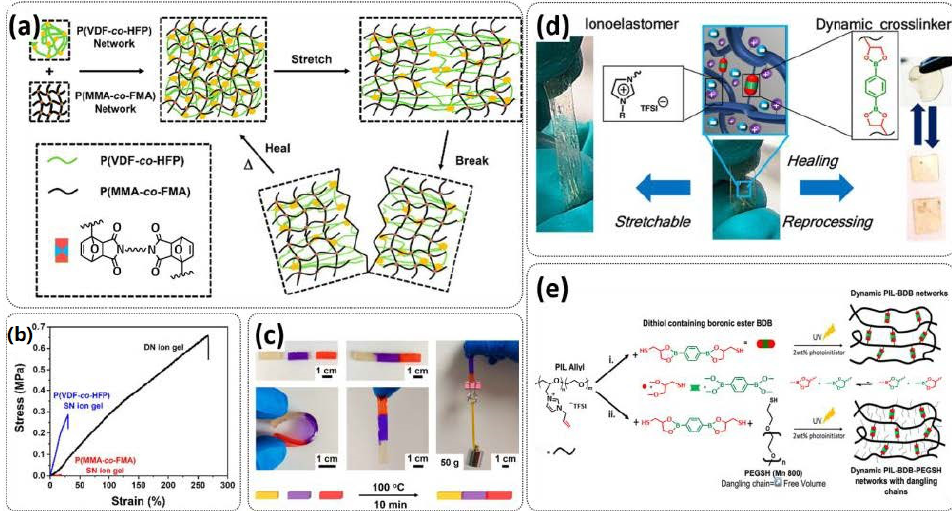
Figure 11. ( a ) P(FMA- co -MMA)/P(VDF- co -HFP)/(EMIM)(TFSI) DN ion gel and its self-healing mechanism. ( b ) Tensile stress – strain curves of the DN and the respective SN ion gels. ( c ) Thermal healing capability of the DN ion gel. Reproduced with permission from [94]. Copyright © 2018, American Chemical Society. ( d ) Concept and ( e ) synthetic approach towards a vitrimeric ionoelastomer. Reproduced from [98].